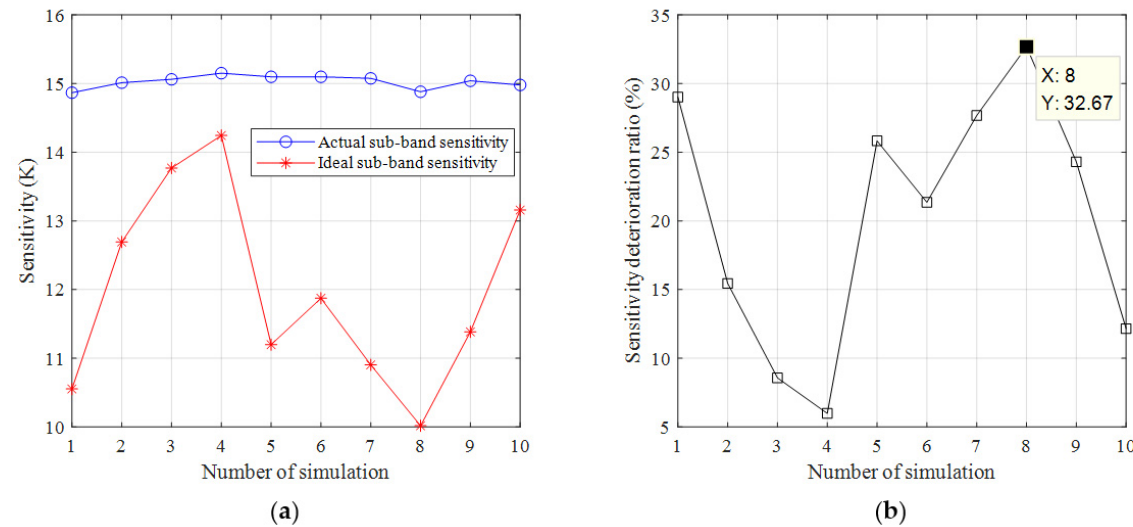
Figure 11. The sub-band sensitivity comparison and deterioration obtained by multiple simulations: ( a ) actual sub-band sensitivity and ideal sub-band sensitivity; ( b ) sub-band sensitivity deterioration